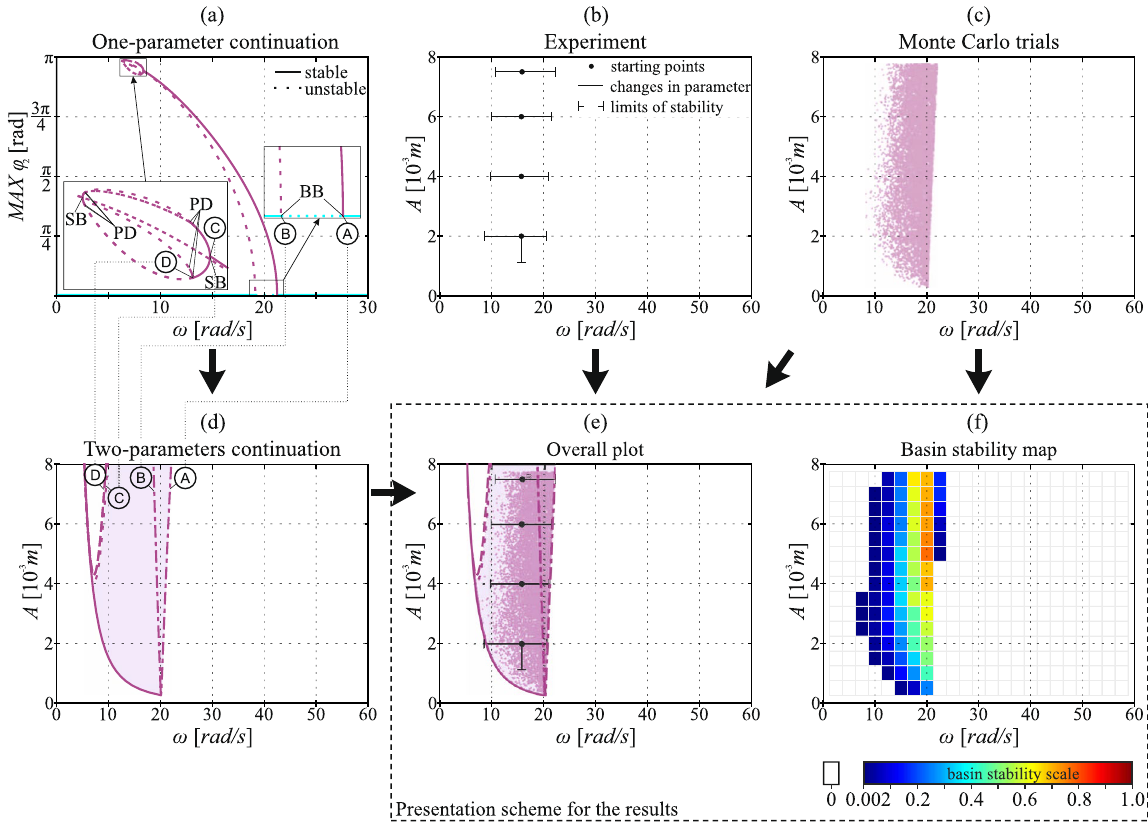
Figure 2. Presentation scheme for the stability analysis obtained using different approaches for 1:2 oscillatory solution. Panels (a,d) were obtained from the continuation of a periodic solution, in panel (b) we present experimental data and in panels (c,f) the results obtained with a sample-based method. In subplot ( c ) we compare the three approaches. Abbreviation used in panel (a) indicate the following bifurcations: PD - period doubling, SB - symmetry breaking pitchfork and BB - branching point where the equilibrium destabilizes and lower pendulum starts to move. Points where the bifurcations occur in panels (a) and (d) are marked with capital letters A–D. Henceforth, we will use two figures such as panels (e) and (f) to provide critical comparison between the